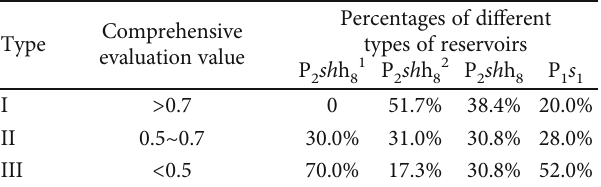
Table 4: Reservoir types based on di ff erent comprehensive evaluation values in the study